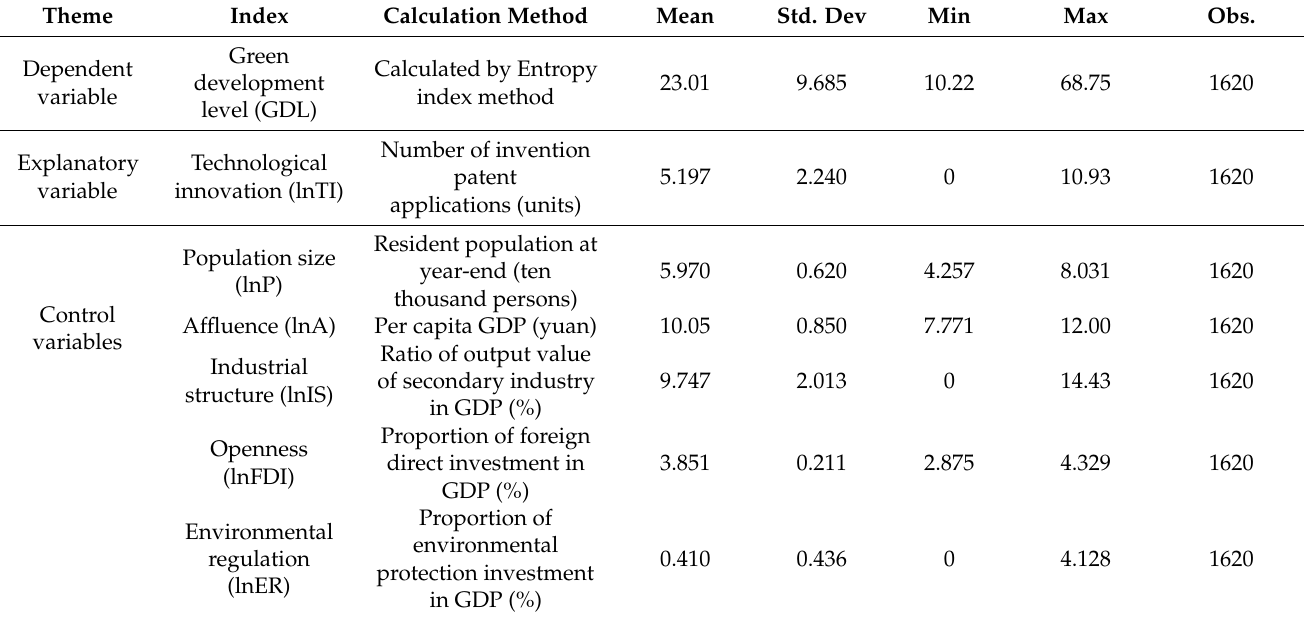
Table 2. Descriptive statistics of